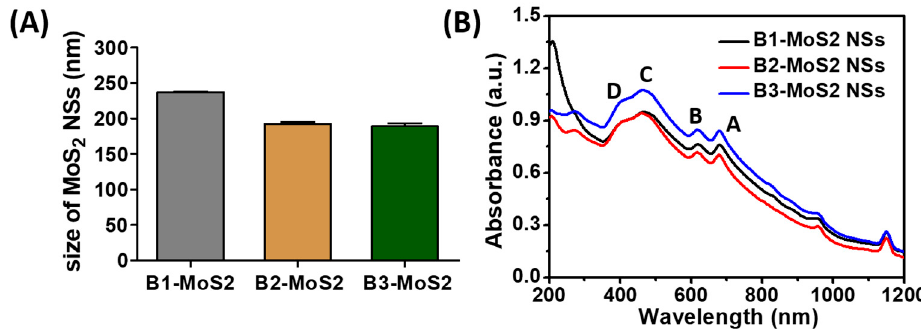
Figure 3. ( A ) DLS and ( B ) UV-visible absorption spectra of synthesized MoS 2 NSs.